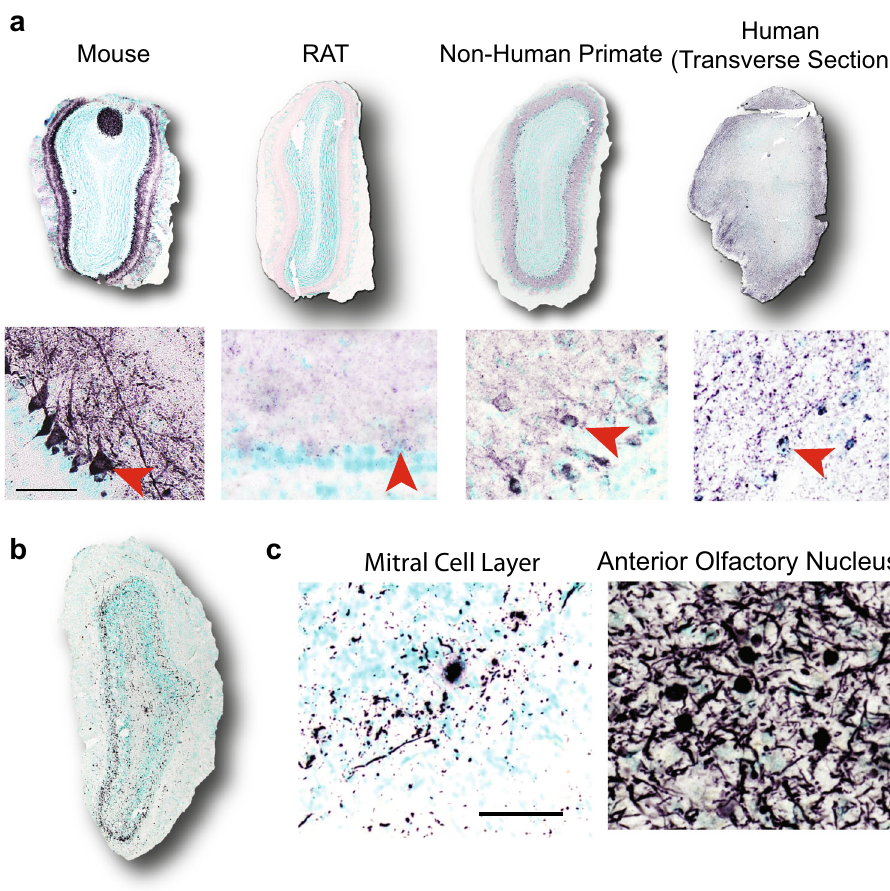
Fig. 3 Mitral cell PSER129 is conserved across species. a Representative images of PSER129 staining in OB sections from mice, rats, non- human primates, and humans. All sections were coronal, except for human OB, which was a section in the transverse plane. Depicted below each OB are high-magni fi cation images of staining in the mitral layer. Scale bar = 50 µ. Red arrowheads indicate positive PSER129 mitral cells. b Representative images of PSER129 staining in PD/DLB OB. Section from the main bulb depicted. c High-magni fi cation images show PSER129 staining in the mitral cell layer and anterior olfactory nucleus. Scale bar = 50